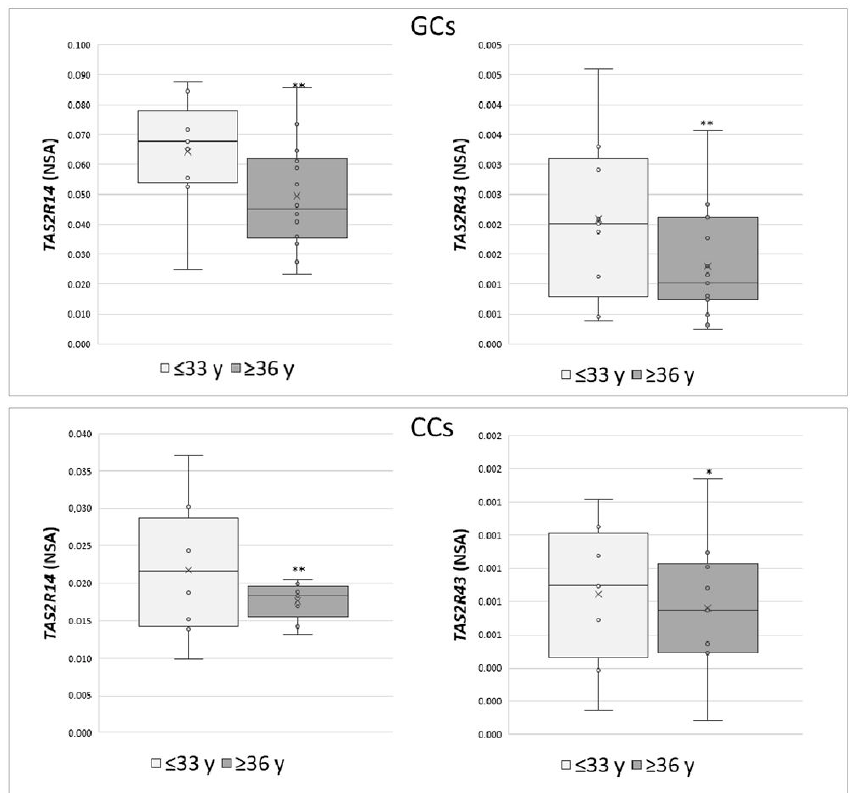
Figure 3. Relative NSA levels in GCs and CCs for TAS2R14 and TAS2R43 . Graphical diagrams are plotted as box–whisker plots, where boxes show the interquartile range with median and mean values, and whiskers represent min and max confidence intervals. Statistically significant differences in mRNA levels were tested by Mann–Whitney test. * p < 0.05, ** p < 0.01.